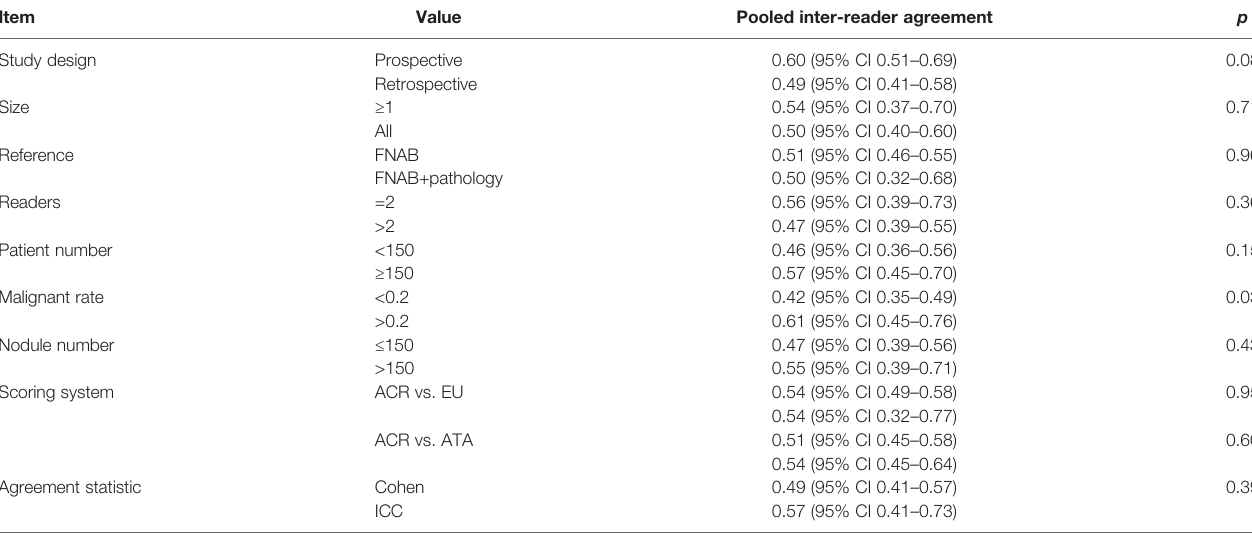
TABLE 3 | Meta-regression analysis.